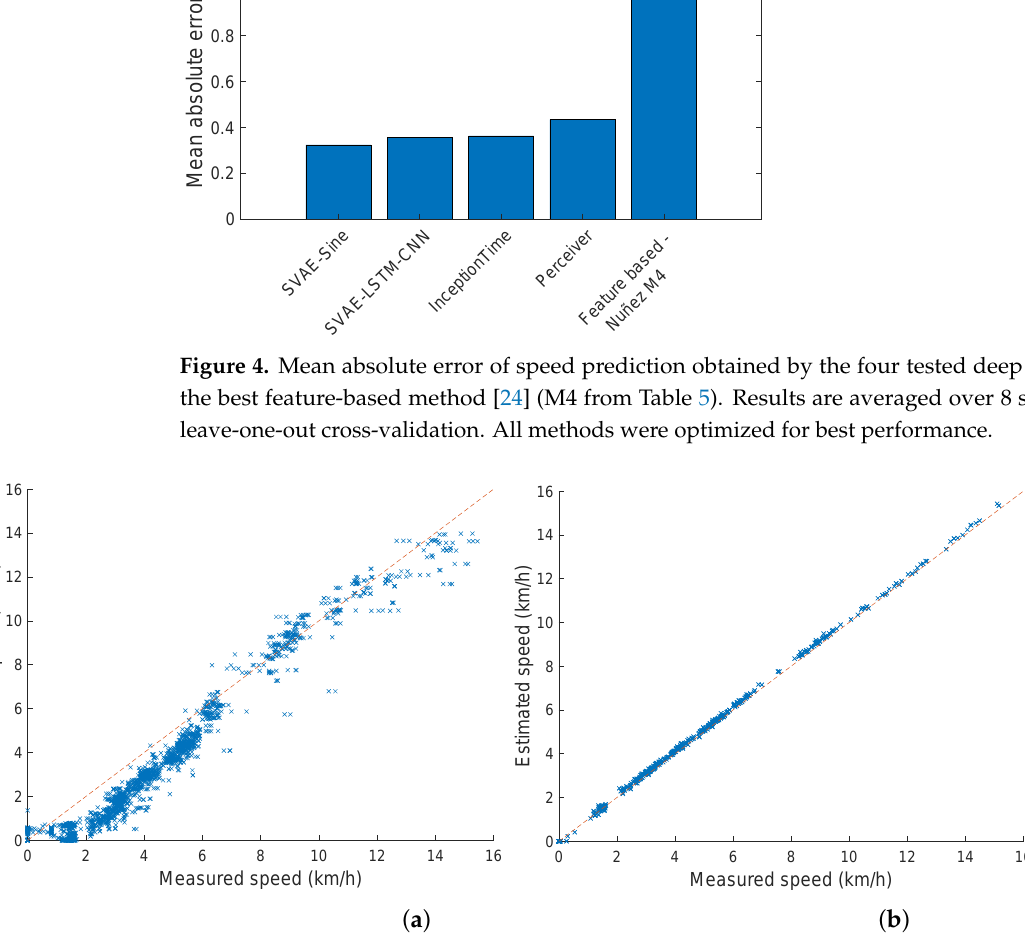
Figure 5. Scatter plot of measured and predicted speed of tested subject number 1 (unseen in training) for two prediction methods: the best performing conventional methods of [24] and the best performing deep method SVAE-Sine. ( a ) feature-based method 4 of [24]. ( b ) deep architecure SVAE-Sine. Dotted line indicates perfect